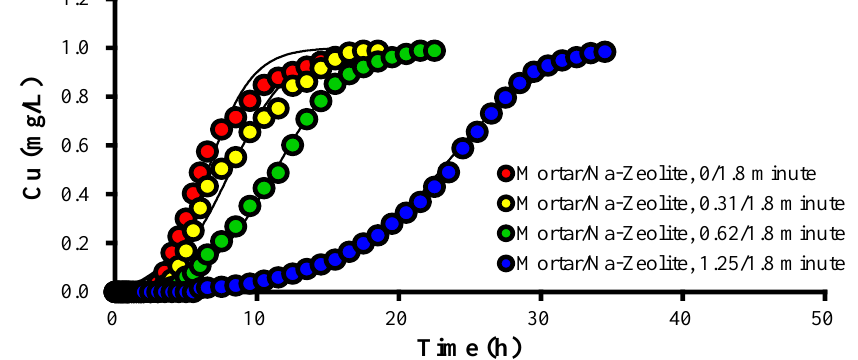
Figure 3. Variations over time in the concentration of Cu 2+ ions in the effluent collected after the dual layer, in mg/L, for different ratios of EBCTs; the working temperature is 20.5 °C.